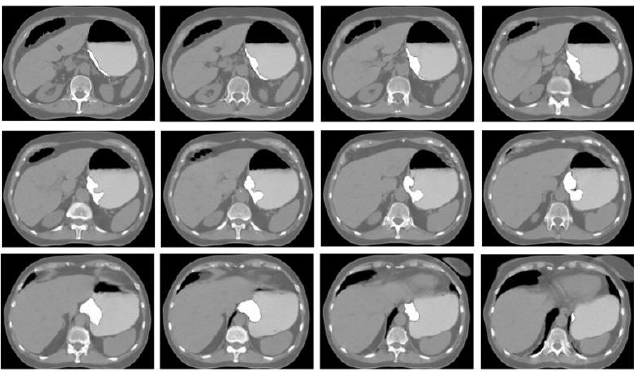
Fig. 4. The variety of grayscale images from the CT scans dataset [29]. Each CT volume has 450–1167 slices of 512 × 512